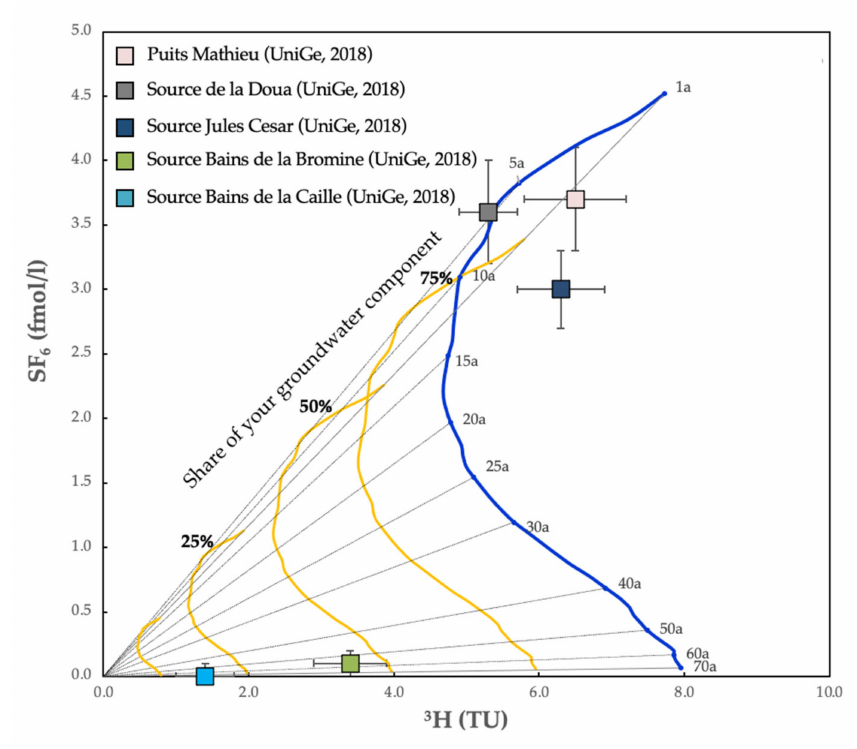
Figure 15. Harp plot correlation Tritium and SF 6 data to estimate the residence time for the springs sampled in the Geneva area (credits: Hydroisotop Gmbh).